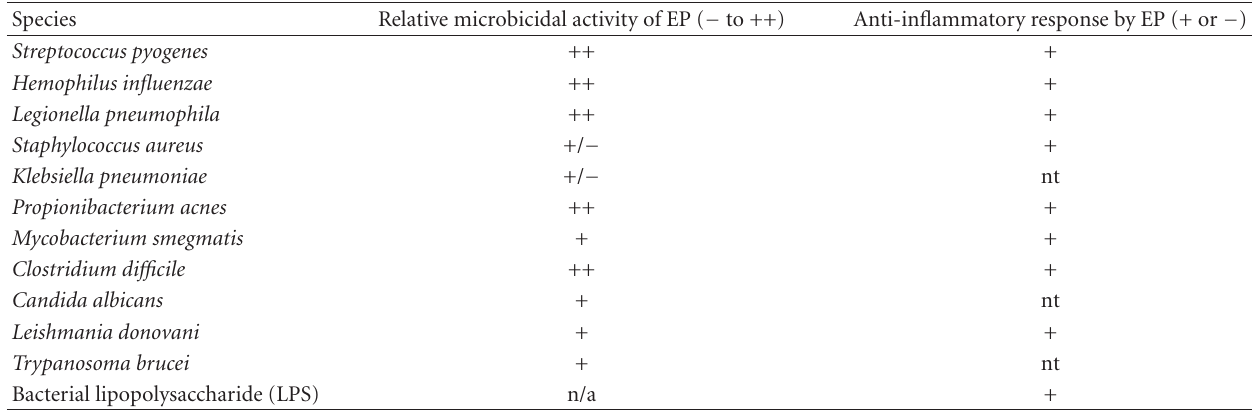
Table 6: Antimicrobial e ff ects of EP.